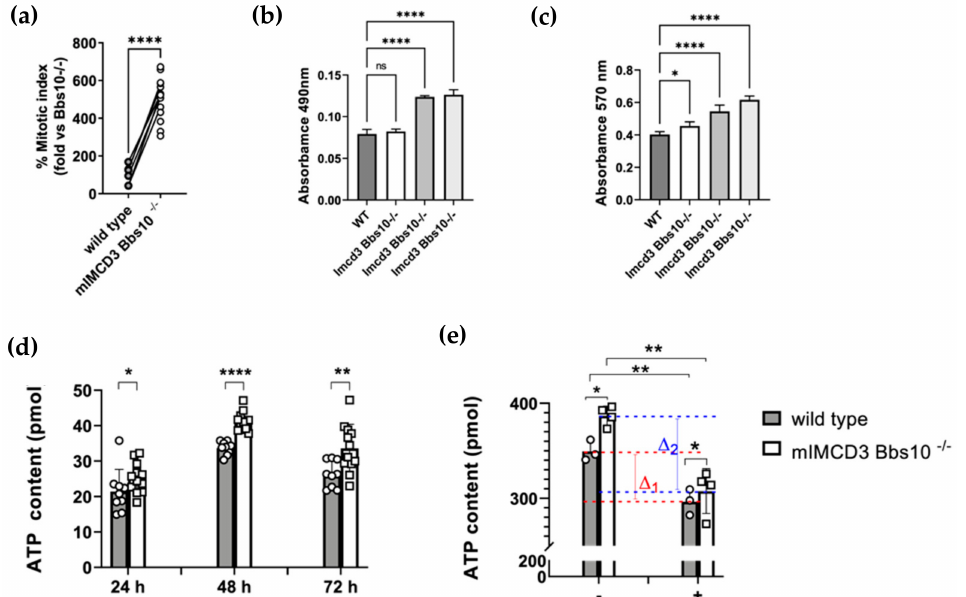
Figure 3. Bbs10 deficiency is associated with an increase in cellular proliferation rate and enhanced basal ATP production. ( a ) IMCD- Bbs10 -/- showed an increase in proliferation compared to wild type cells. The mitotic index was calculated as the ratio of the number of cells undergoing mitosis to the total number of cells and expressed as a percentage. ( b ) Absolute quantification of cell survival was performed by measuring the absorbance at λ = 490 nm. The difference between the absorbance of